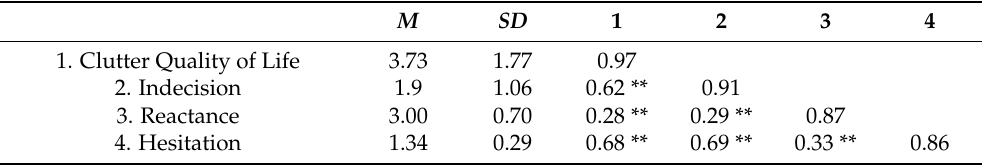
Table 1. Mean, Standard Deviation, Cronbach’s alpha, and Correlations between Psychometric Variables. Table 2. Goodness of fit measurements for 2-class and 3-class models.